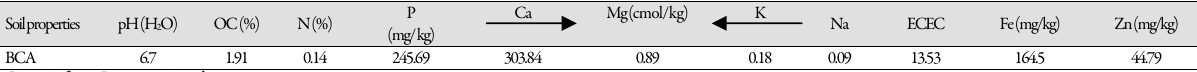
Table 1. Physico-chemical properties of experimental soil